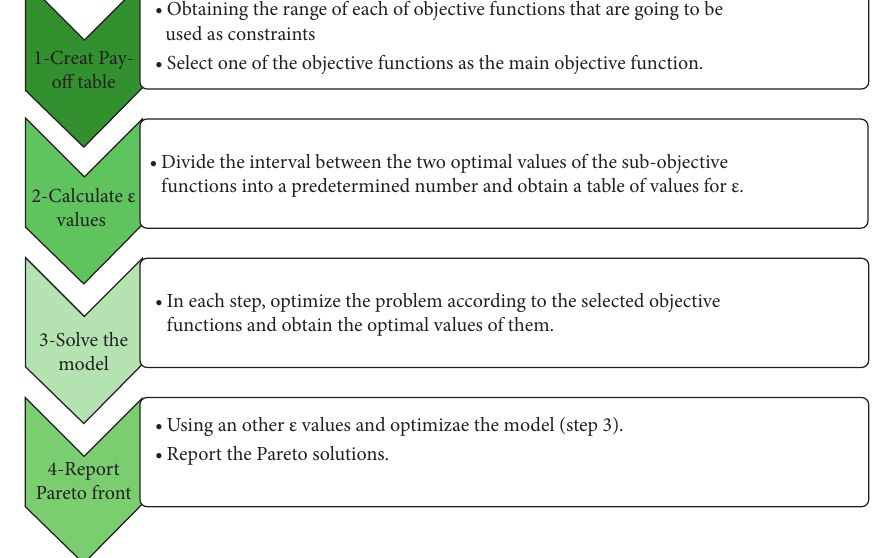
Figure 2: The steps of the ε -constraint method.